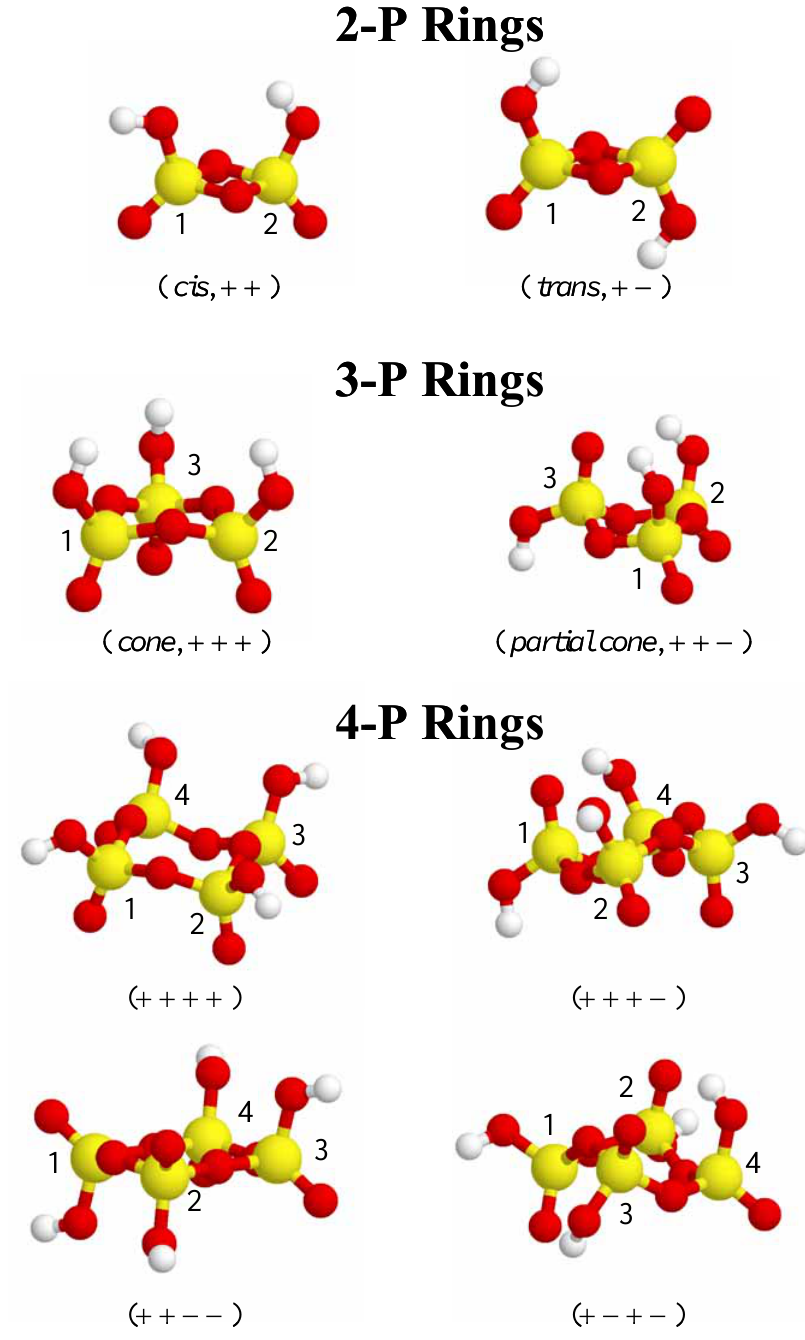
Figure 2. Different conformations for 2-P, 3-P, and 4-P-membered cyclic phosphate clusters. Phosphorus is depicted as yellow, oxygen is red, and hydrogen is white. The +/ − nomenclature refers to the relative orientation of the terminal P=O bonds (see text for details). Each phosphorus nuclei has a number ID for identification with 31 P CSA tensor values in Table